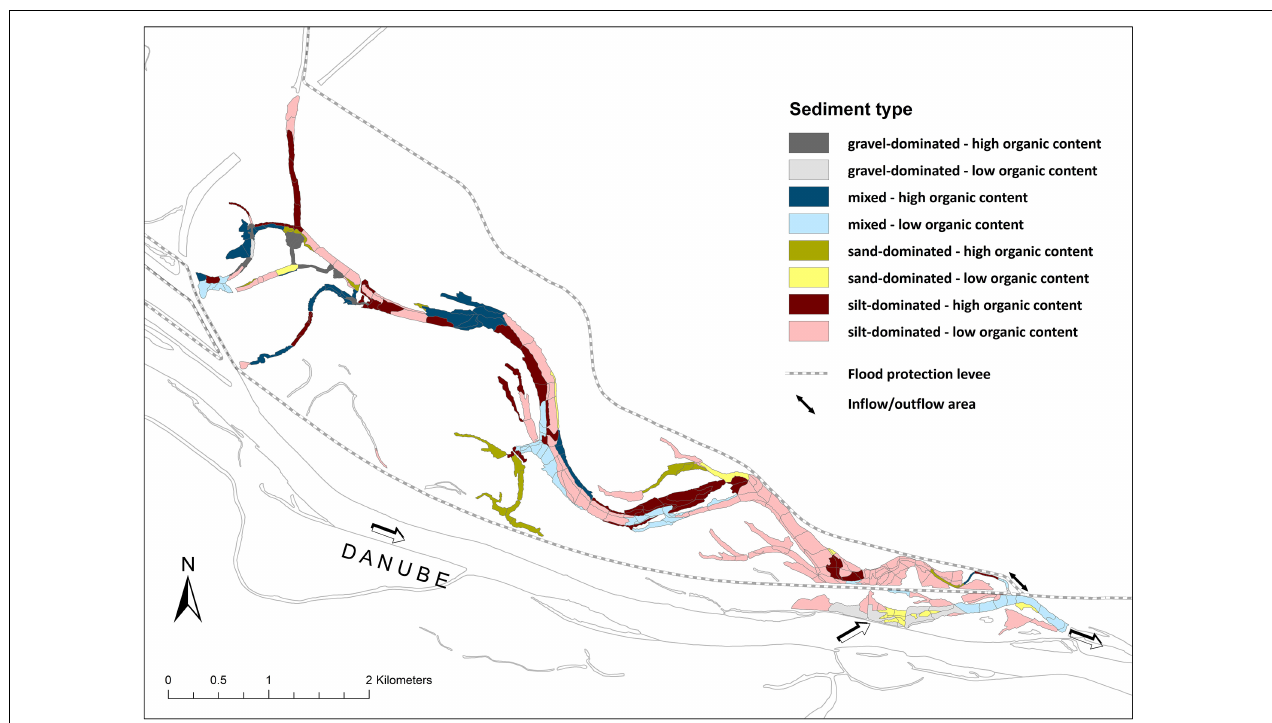
FIGURE 2 | Distribution of the predominating sediment types in the Lower Lobau.